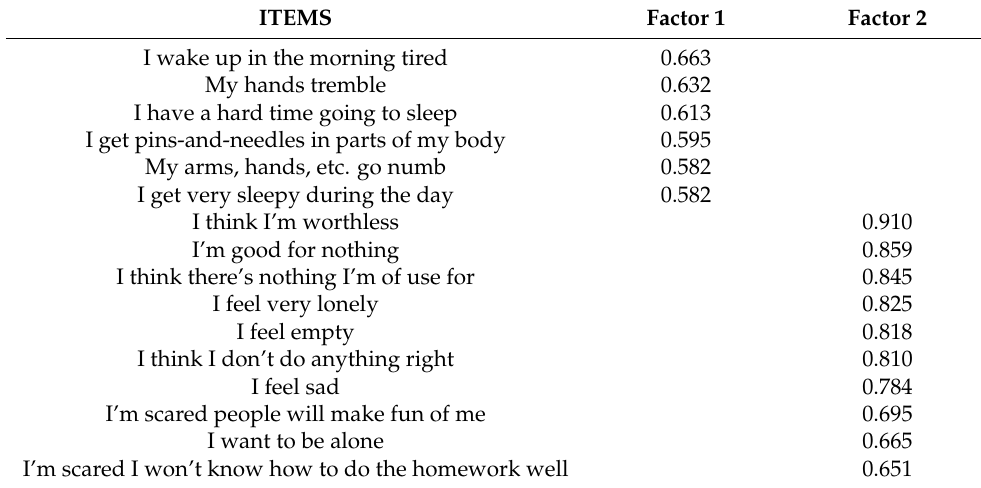
Table 5. Structure matrix of the emotional problems detection